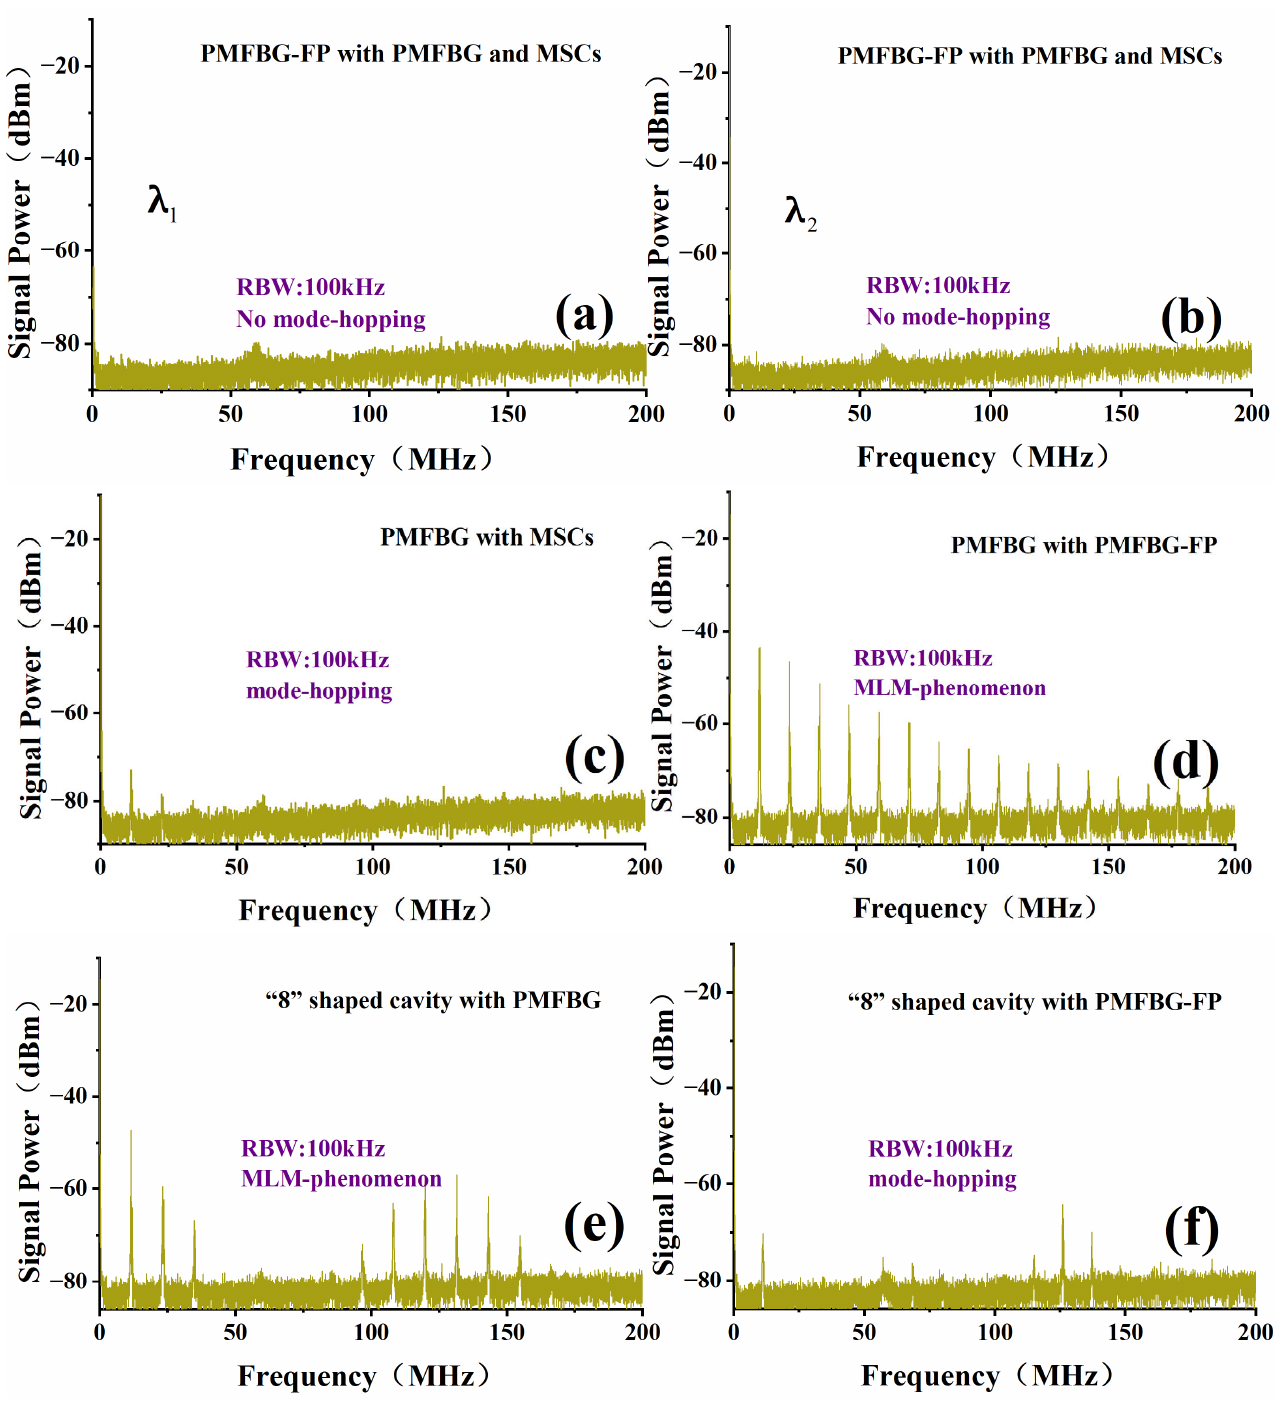
Figure 9. Electrical spectra of the beat signal accumulated within half an hour. ( a , b ) Beat signals of λ 1 and λ 2 under the conditions of a combination of narrow-band PMFBG-FPs with PMFBG and MSCs, respectively. ( c ) Only MSCs were retained without binding the PMFBG-FP. ( d ) Only the PMFBG-FP was retained without binding the MSCs. ( e ) Only the “8”-shaped cavity is retained without binding the PMFBG-FP. ( f ) The “8”-shaped cavity cascade PMFBG ‐ FP.